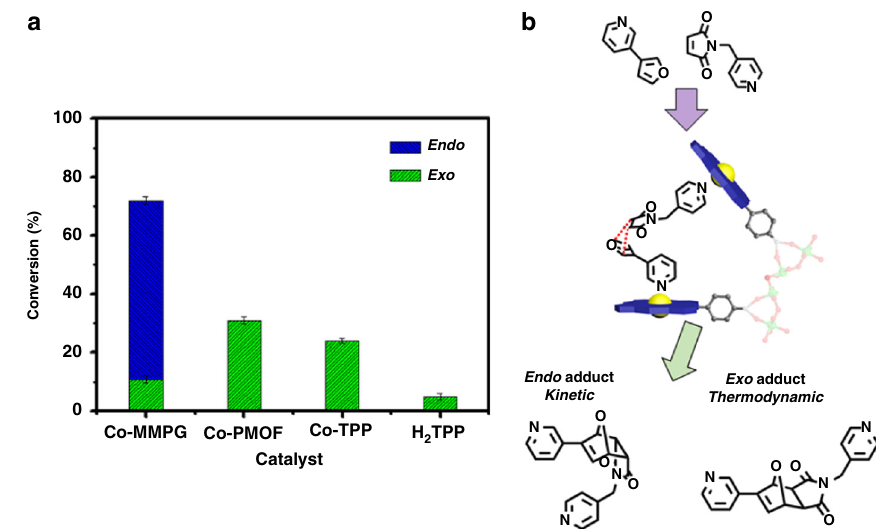
Fig. 5 Catalytic performance for Diels – Alder reactions. Conversion and selectivity of exo and endo reactions in the presence of various catalysts ( a ) and Diels – Alder reaction between a diene and dienophile which are designed to react within Co-MMPG ( b ). The conversion and selectivity represent the standard deviation from the repeated experiment after three times. Source data are provided as a Source Data fi